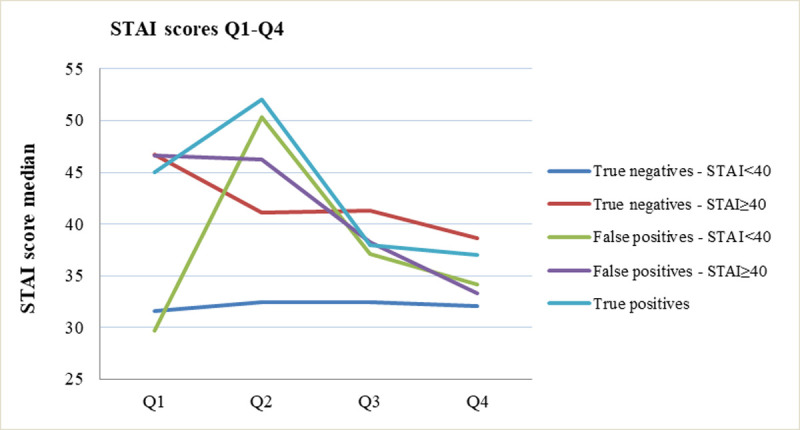
Median STAI scores before and after the 13-week and 20-week anomaly scans by subgroup.In women with true-negative results and STAI≥40 at Q1 (n = 312, 27.9%), anxiety was significantly lower after the 13-week scan (Q2: 40.0, 33.3–46.7 vs. Q1: 46.7, 40.0–50.0, p<0.01) and further decreased after the 20-week scan (Q4: 36.7: 33.3–43.3 vs Q3: 40.0: 36.7–46.7, p<0.01). In women with true-negative results and lower initial STAI-scores (STAI<40) (n = 707, 62.2%), no significant differences in median STAI-scores were found (Q2: 33.3, 30.0–36.7 vs Q1: 33.8, 26.6–36.7; p = 0.21 and Q4: 33.3, 26.7–36.7 vs Q3: 32.1, 24.6–35.2; p = 0.57).